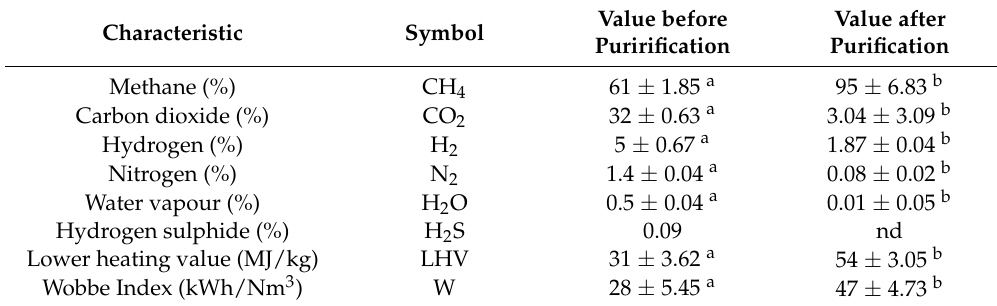
Table 4. Biogas composition before and after